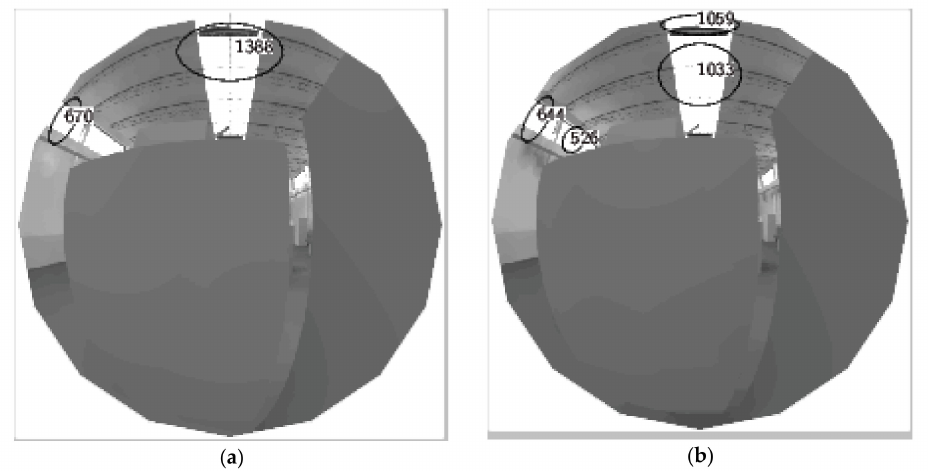
Figure 7. Result of simulated glare sources at the workplace for overcast sky conditions: ( a ) wire skylight glazing; ( b ) di ff use skylight